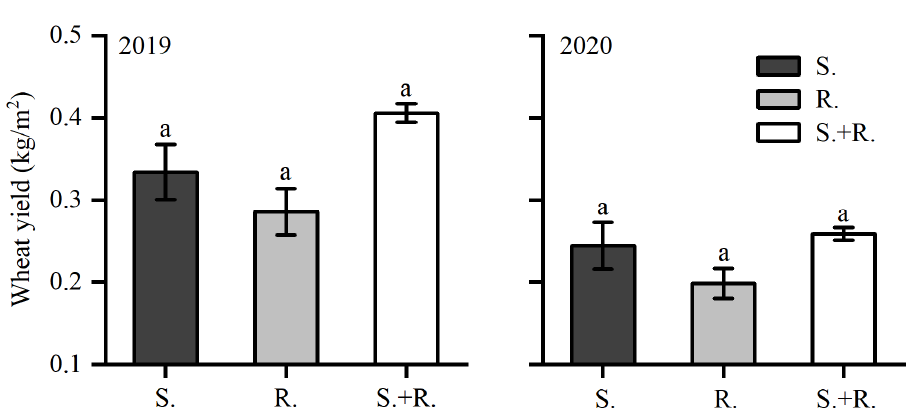
Figure 3. Yield of wheat of susceptible varieties (S.), resistant varieties (R.), and susceptible and resistant varieties (S+R: 5-cultivar mixture) grown in 2019 and 2020. Not significantly different means within each treatment are indicated by the same lowercase letters according to the SNK test: 2019 ( F 2, 13 = 3.071, p > 0.05); 2020 ( F 2, 13 = 2.021, p > 0.05).